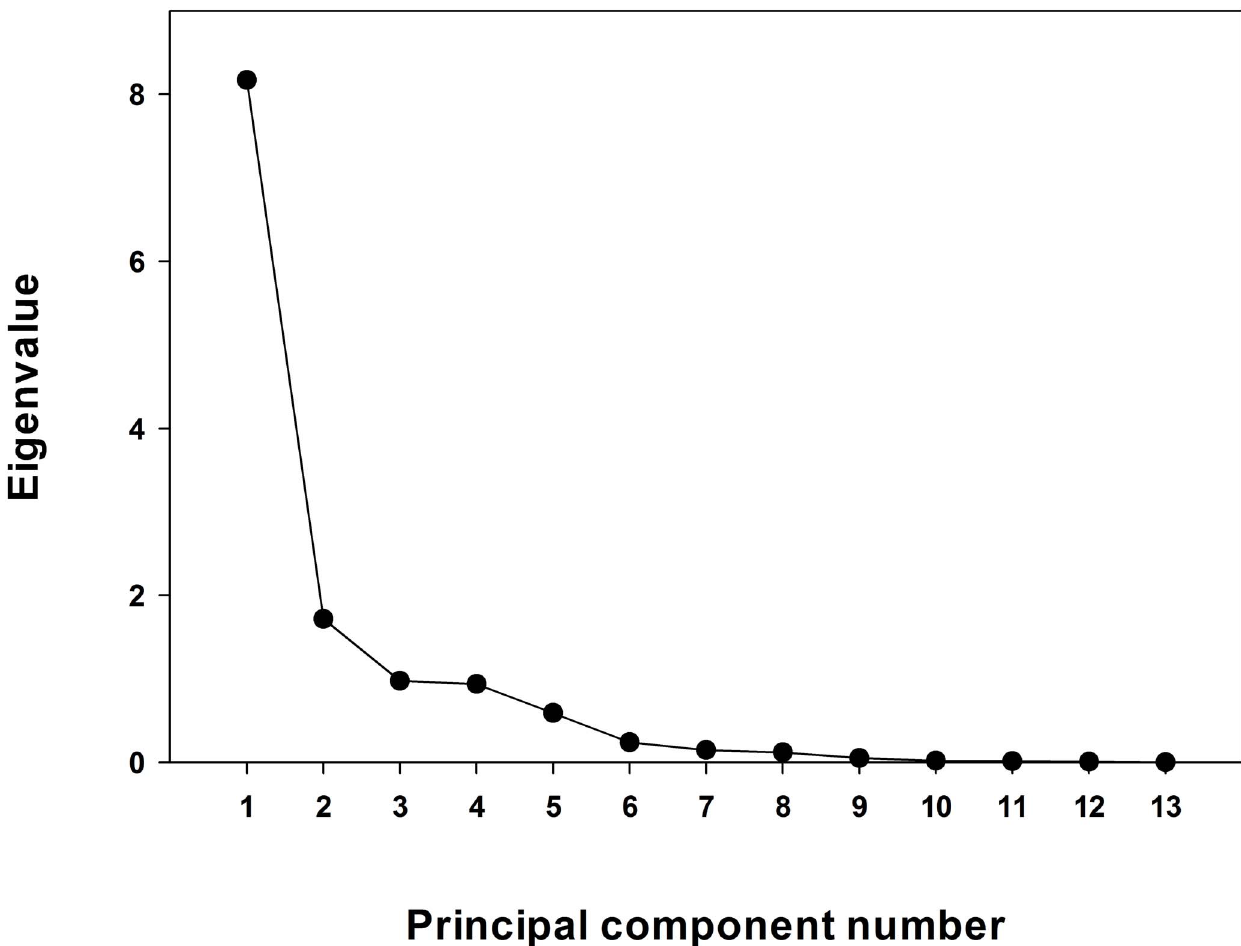
Figure 1. Scree plot of principal component analyses.